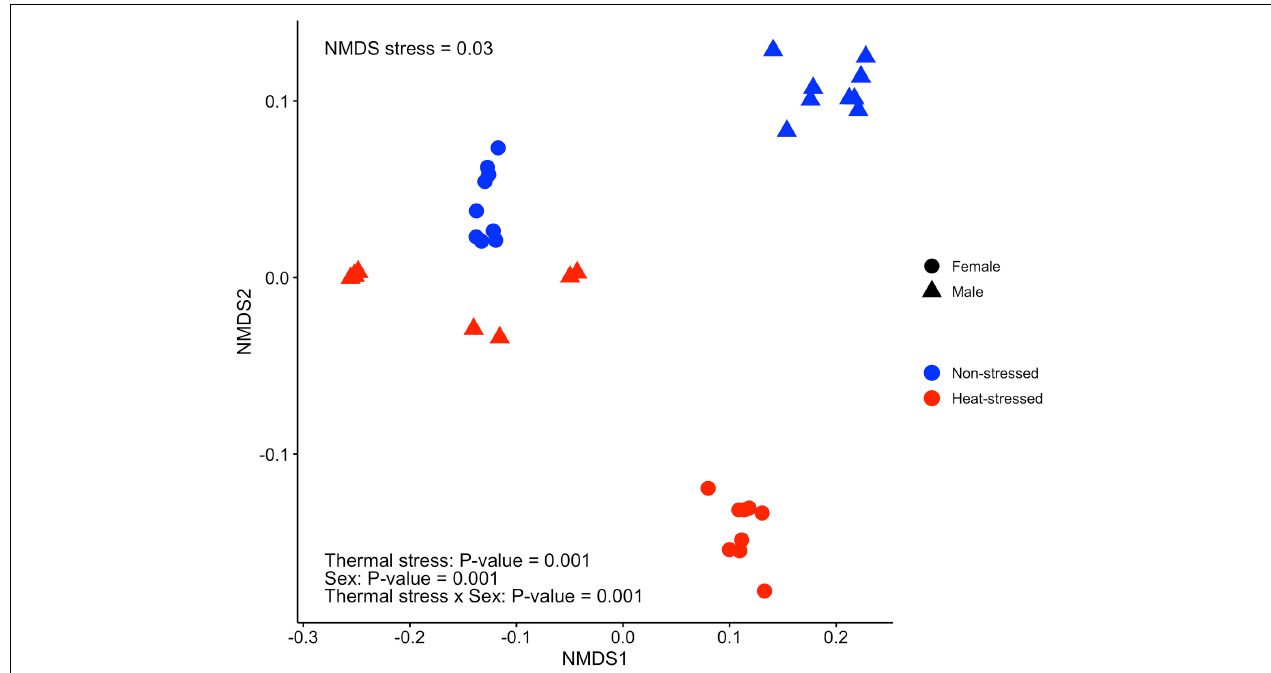
FIGURE 5 | Bacterial community structure estimated for the gut microbiota of Drosophila subobscura using non-metric multidimensional scaling (NMDS) based on weighted UniFrac distances among samples. Flies of each sex were grouped into non-stressed (exposed to 21 ◦ C) and heat-stressed (exposed to 34 ◦ C)